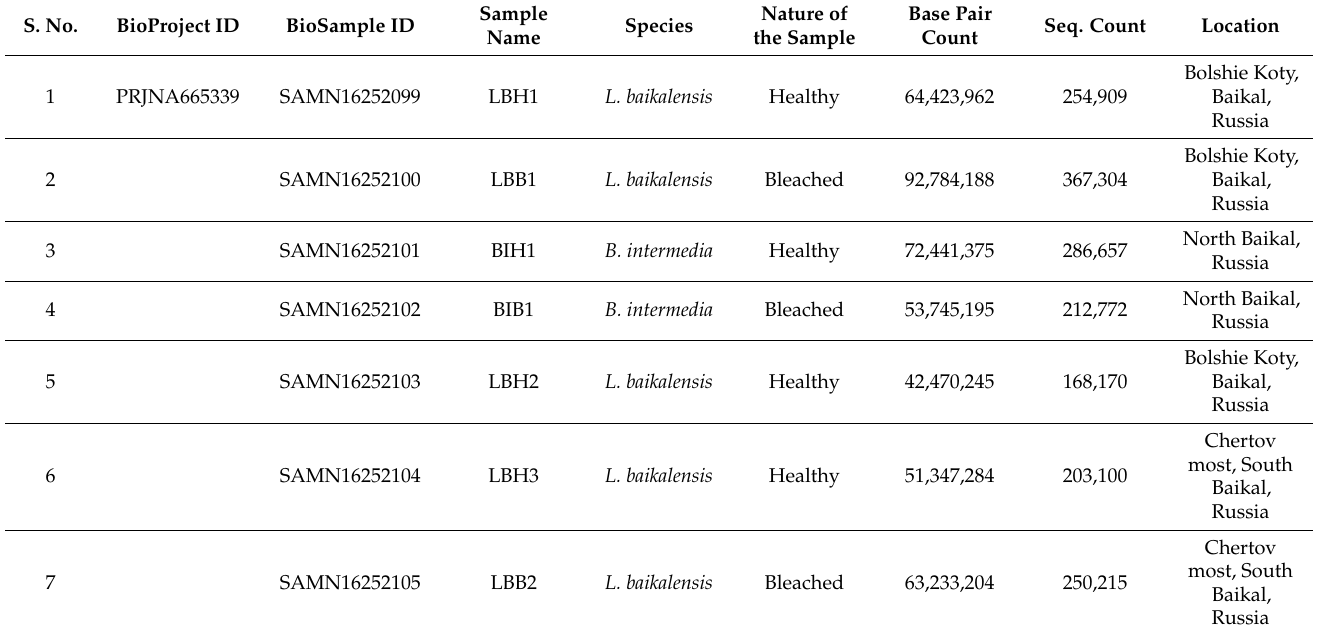
Table 1. A detailed experimental determination of the effect of healthy and bleached freshwater sponges Lubomirskiabaikalen- sis and Baikalospongia intermedia collected from Baikal Lake, Russia. S.